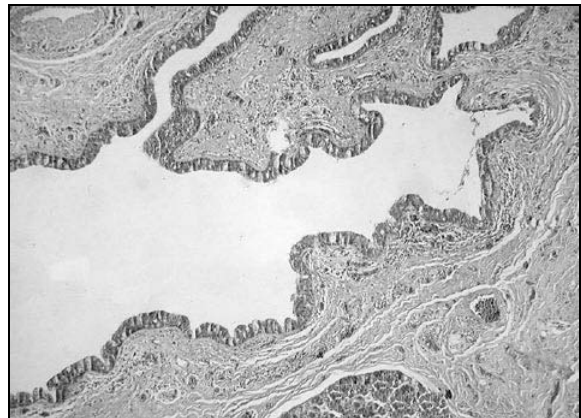
Figura 3 – Ectasia ductal e fibrose periductal